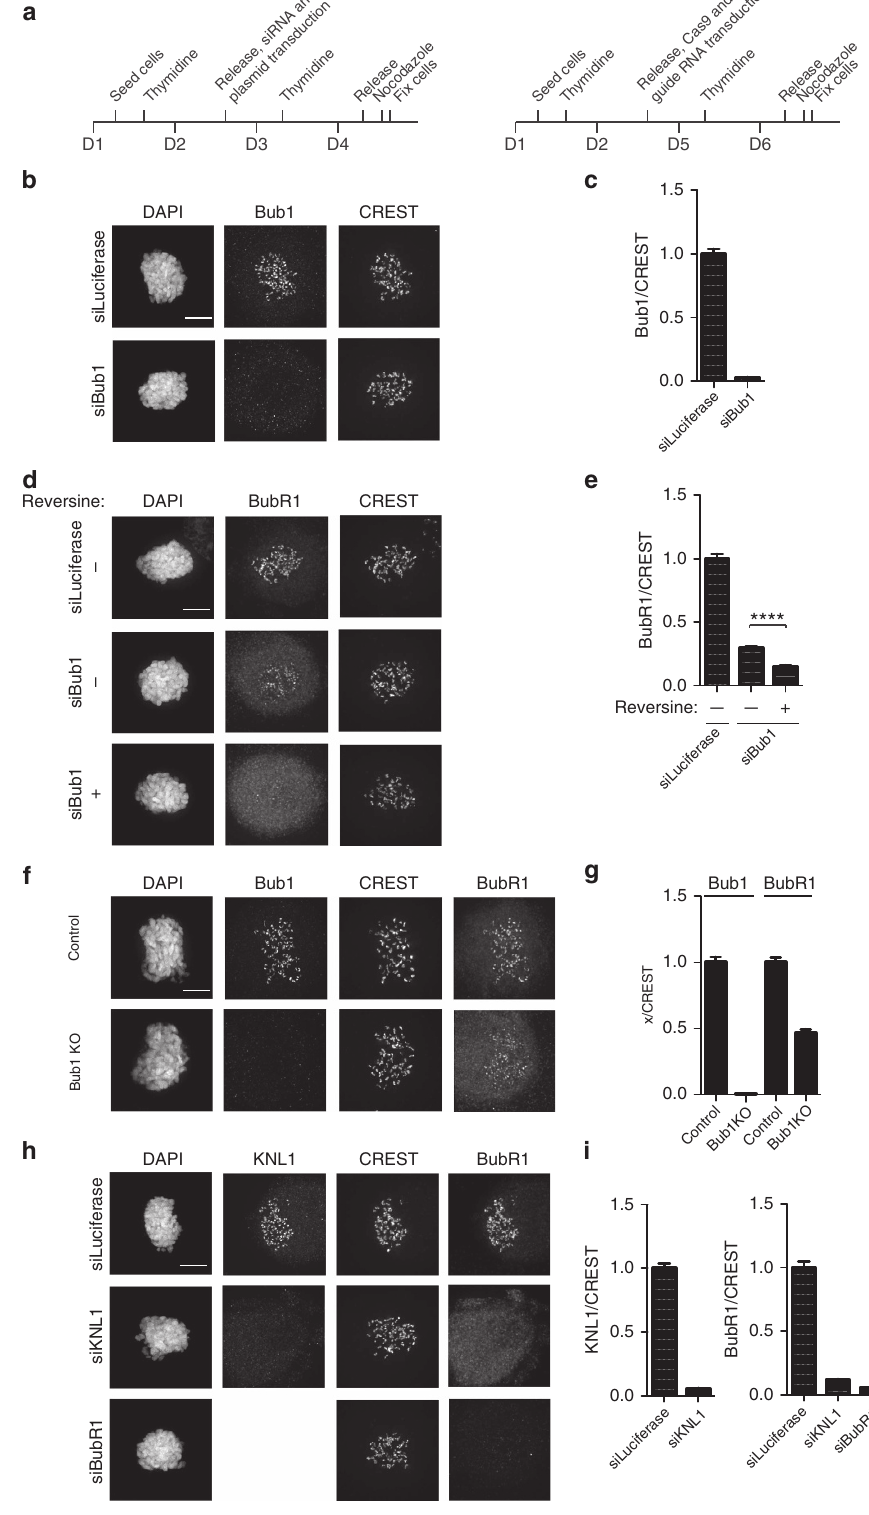
Figure 1 | A Bub1-independent pool of BubR1 at kinetochores. ( a ) Outline of the synchronization protocol used in this study. Left, RNAi and rescue protocol; right, Bub1 CRISPR/Cas9 knockout protocol. ( b ) HeLa cells were treated with a control RNAi oligo (luciferase) or an RNAi oligo targeting Bub1 for 48h and arrested in mitosis using nocodazole for 2h. Cells were fixed and stained with 4,6-diamidino-2-phenylindole (DAPI), CREST (centromere marker) and Bub1 antibodies. ( c , e , g , i ) The kinetochore levels of Bub1, BubR1 and KNL1 were determined in the indicated conditions and normalized to CREST. An unpaired t -test was used for statistical comparison of the different samples in e . (**** P r 0.0001). ( d ) HeLa cells were treated similarly as in b except reversine (0.5 m M) was added in one condition. ( f ) HeLa cells were transfected with Cas9 protein with guide RNA against Bub1 gene for 96h and treated with nocodazole for 2h. Cells were fixed and stained with DAPI, Bub1, CRESTand BubR1 antibodies. ( h ) HeLa cells were treated with RNAi oligos against luciferase, KNL1 or BubR1 for 48h and arrested by nocodazole for 2h. Cells were fixed and stained with DAPI, KNL1, CRESTand BubR1 antibodies. At least 160 individual kinetochores from eight cells were measured in each condition. The mean with s.e.m. is indicated. Scale bar, 5 m